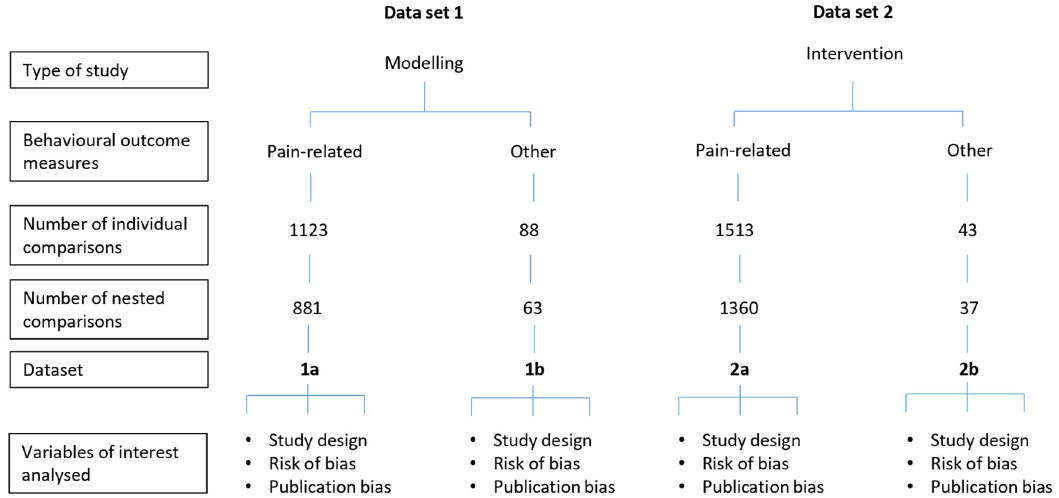
Fig 2. Description and summary of data sets included in this